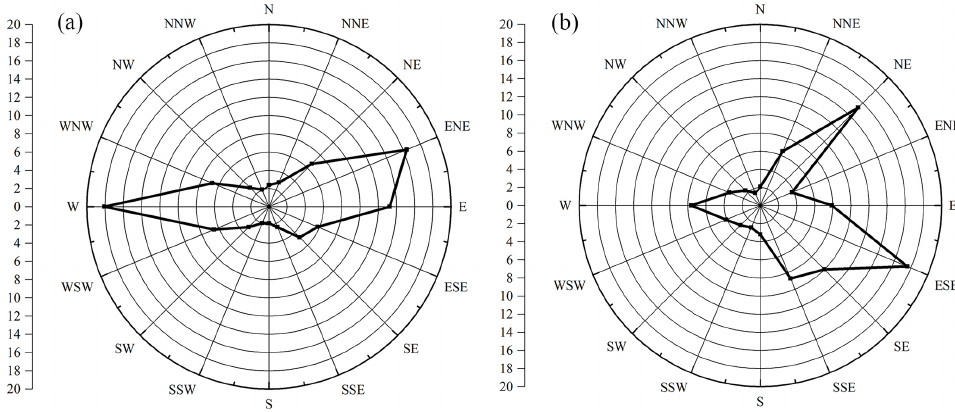
Figure 5. Wind direction frequency at QOMS in the pre-monsoon season: (a) 00:00–12:00BJT; (b) 12:00–24:00BJT.